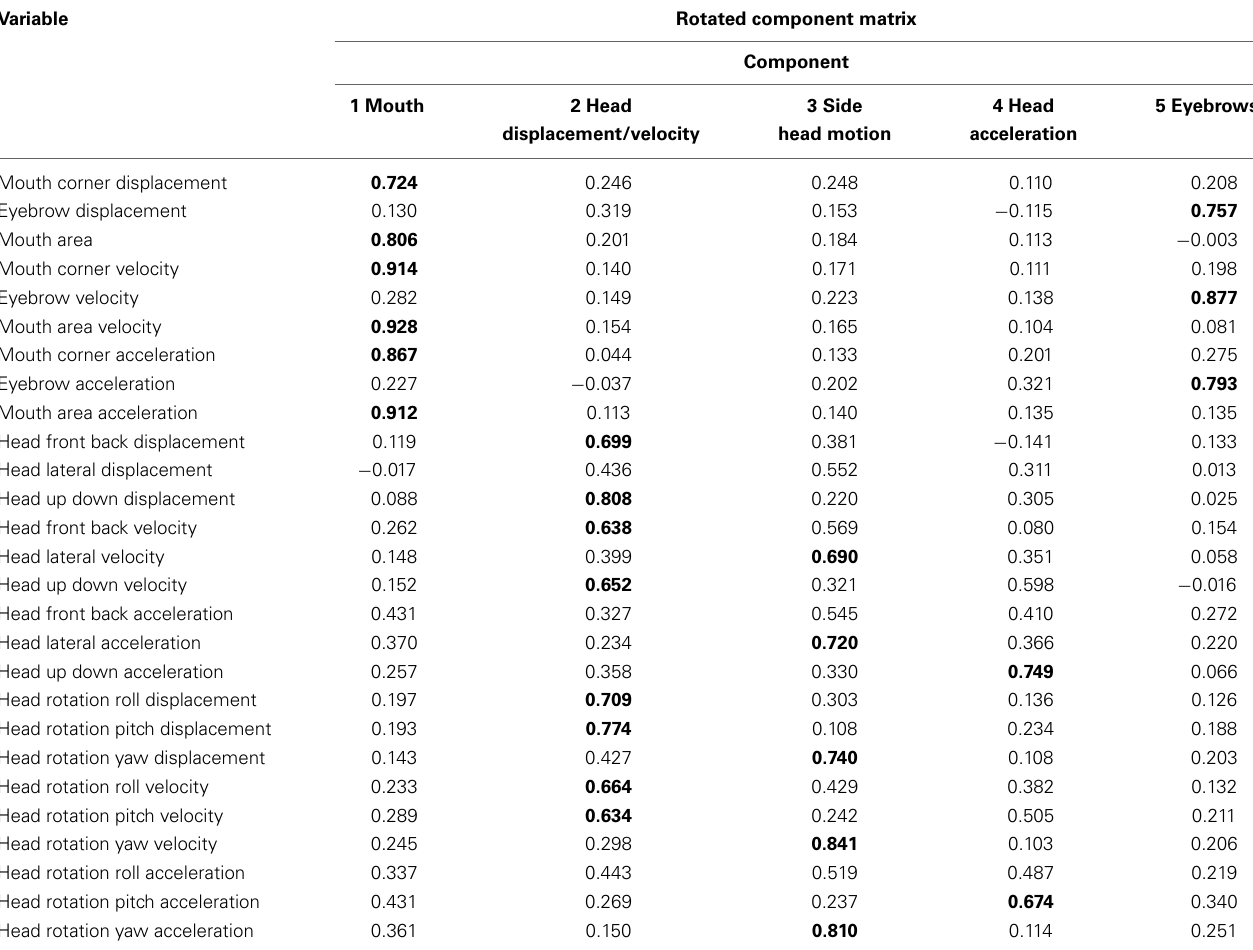
Table 1 | The principal component scores from the rotated component matrix.